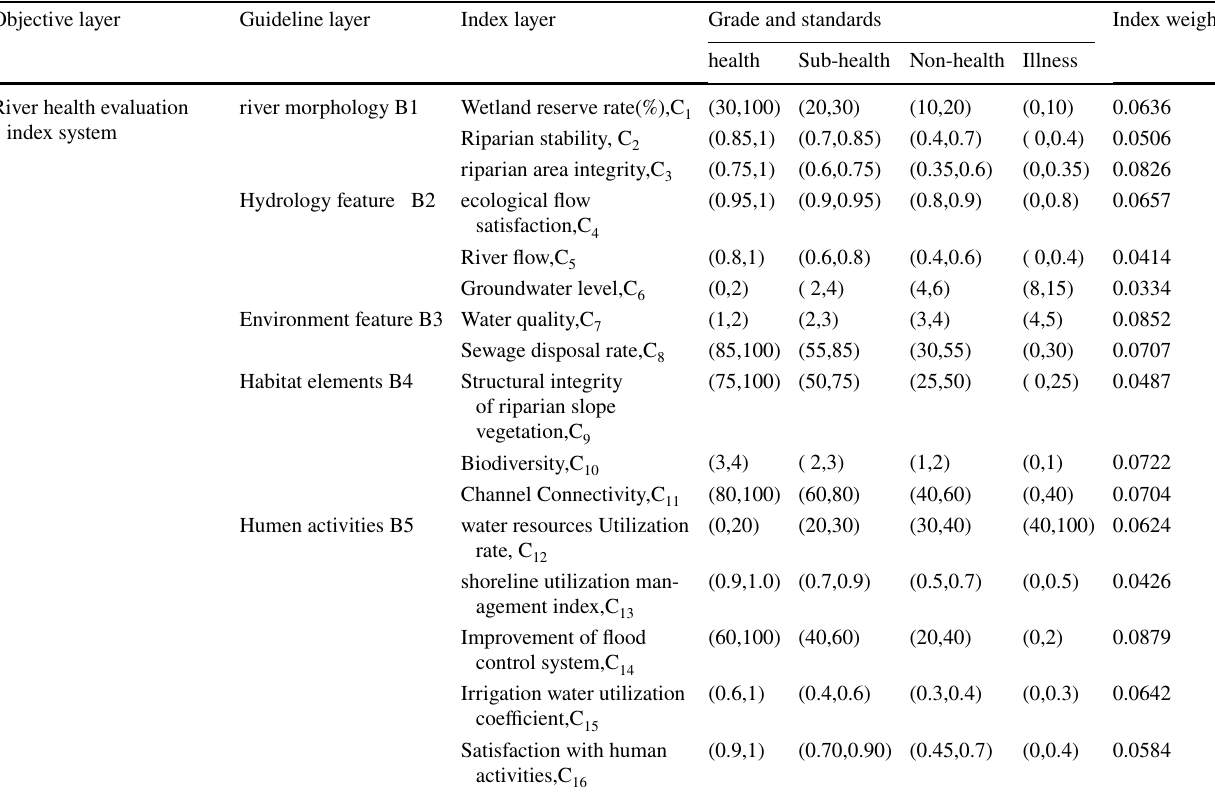
Table 1 The standard index system of river health assessment Objective